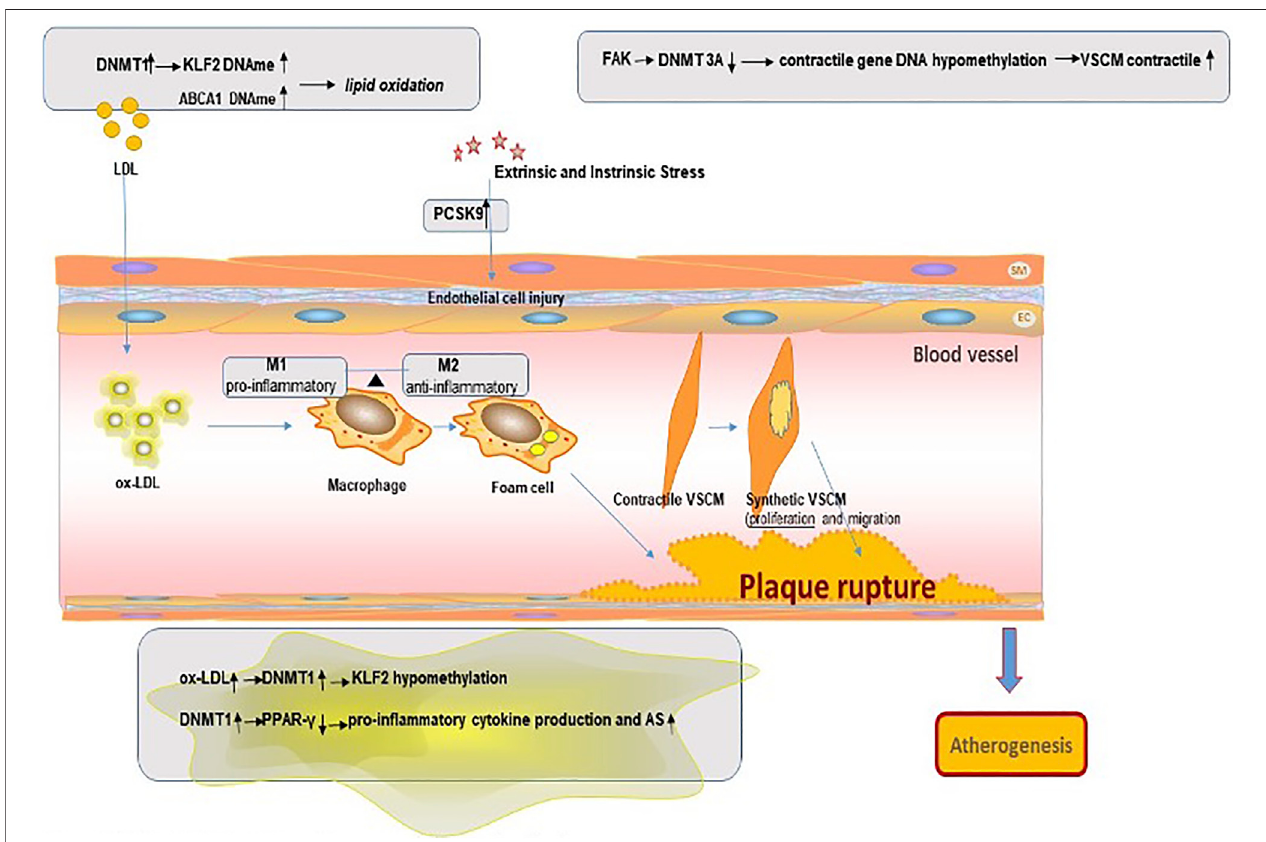
FIGURE 1 | S-Adenosylmethionine is provided by one-carbon metabolism and generates homocysteine.